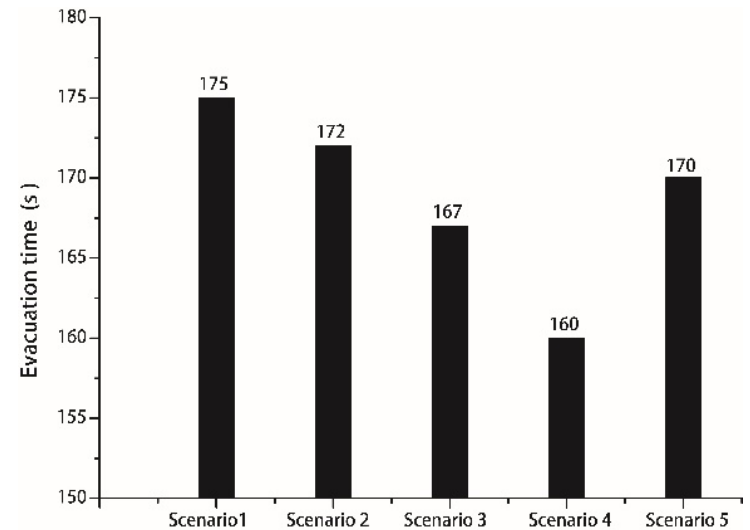
Figure 14. Relationship between total evacuation time and different scenarios.